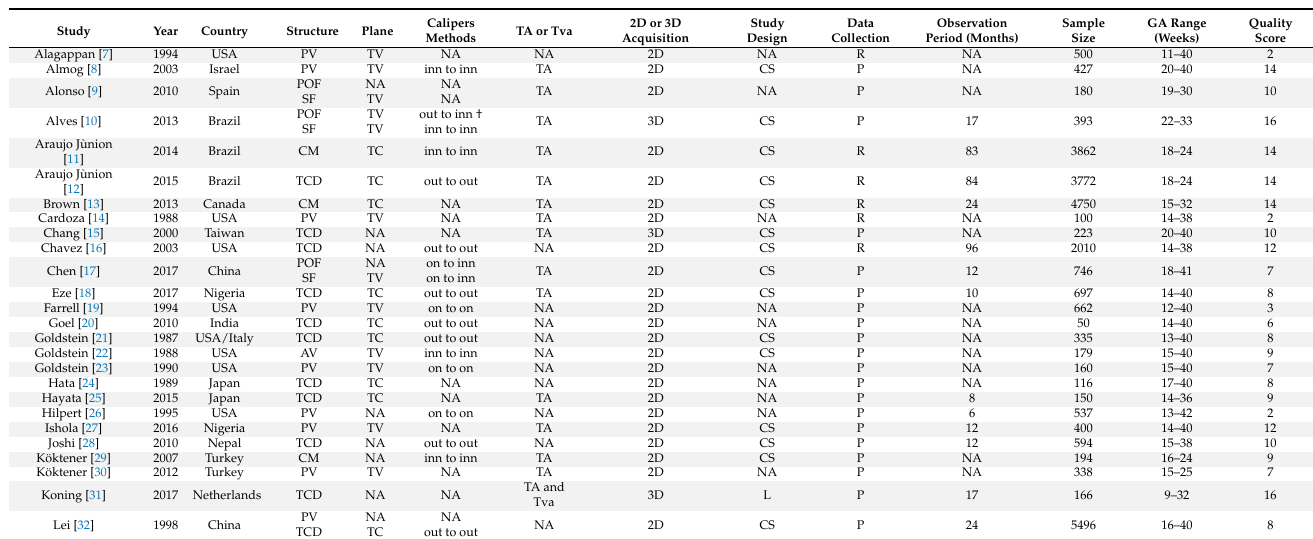
Figure 1. Flow diagram of the studies’ selection process. Table 1. Main characteristics of studies